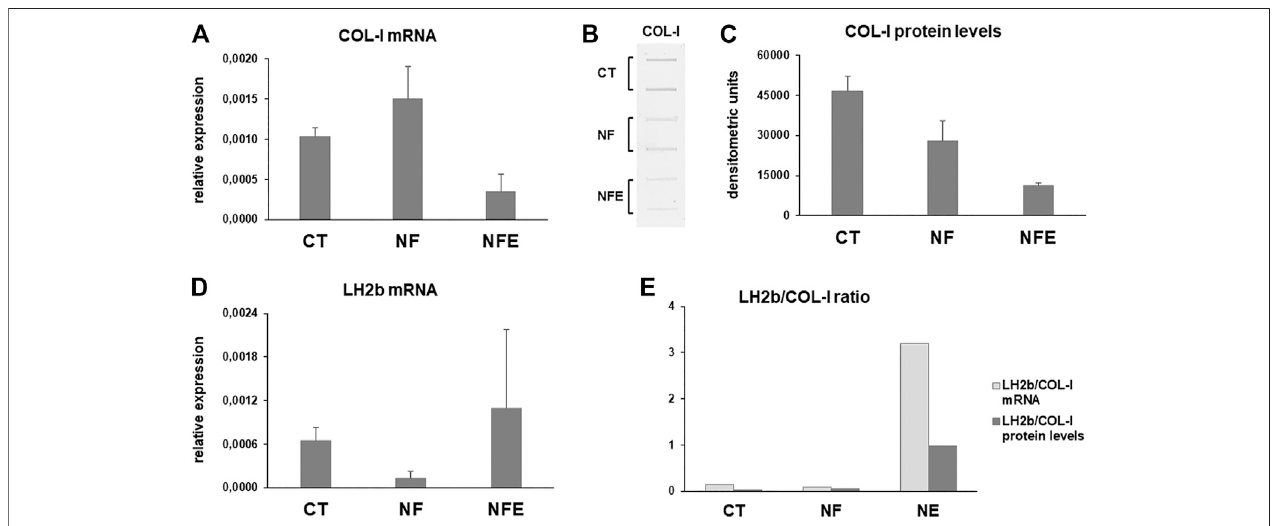
FIGURE5 |(A) Bar graphsshowing COL-I mRNA levels in HGFculturedon NF and NFE. (B) Representative slot blotand bar graphs showing COL-I protein levels (C) secreted in cell culture supernatant of HGF cultured on NF and NFE assayed by slot blot after densitometric scanning of immunoreactive bands in the considered experimental conditions. Data are expressed as mean ± SD of two independent experiments. (D) mRNA levels for long lysyl hydroxylase 2 (LH2b) in CT and cells grown on NF and NFE. Data were normalized on GAPDH gene expression and are expressed as mean ± SD for at least two independent experiments. (E) Bar graphs showing the LH2b mRNA/COL-I mRNA and LH2b mRNA/COL-I protein ratio in the different experimental conditions.